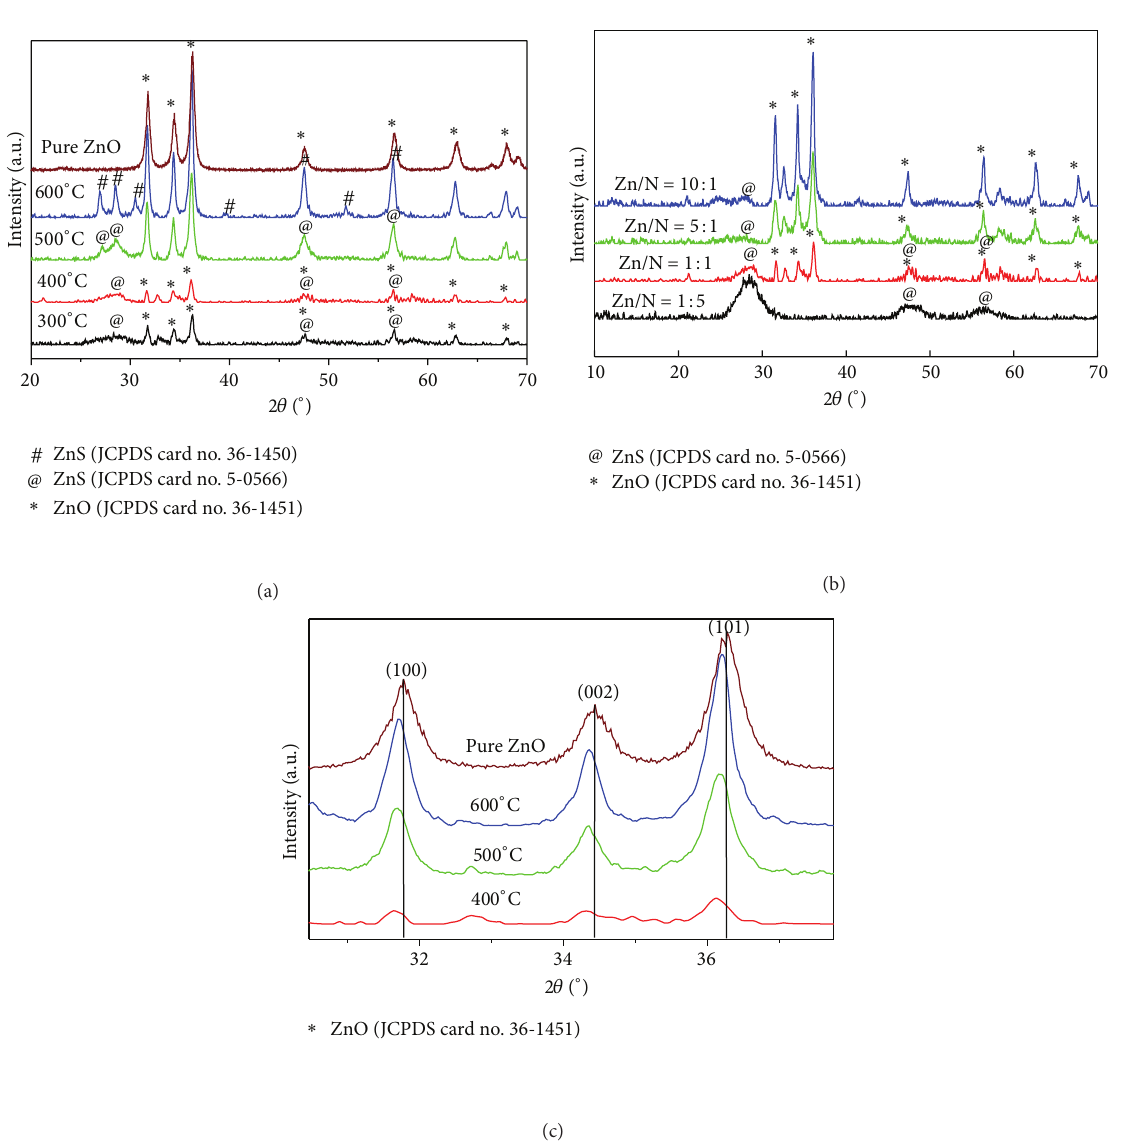
Figure 1: XRD patterns of as-synthesized samples: (a) samples with Zn/N = 1:1 molar ratios calcined at different temperatures, (b) samples with different Zn/N molar ratios calcined at 400 ∘ C, and (c) comparison for peaks position between N-doped ZnO/ZnS composites and pure